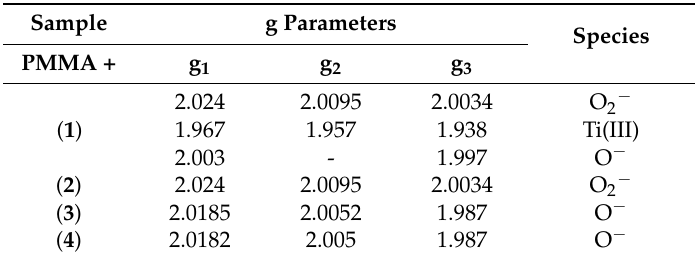
Table 7. Results of EPR studies for UV-Vis irradiated complexes (PMMA foils) ((Ti 4 O 2 (O i Bu) 10 (O 2 CR’) 2